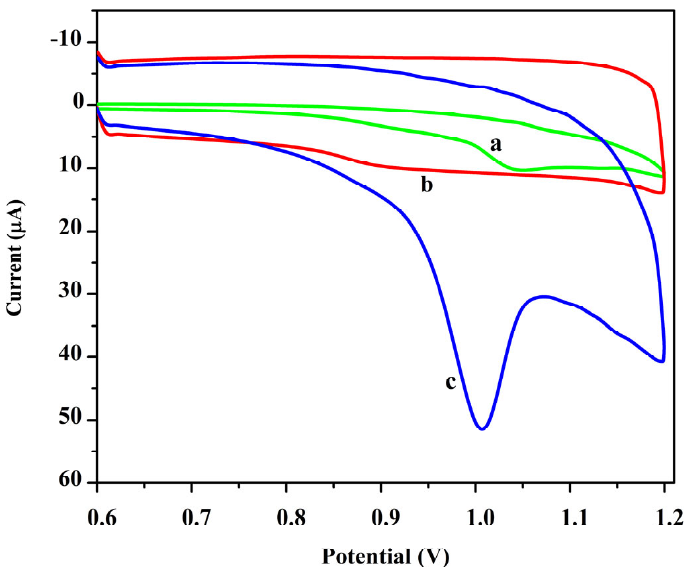
Figure 5. CVs observed for 0.1 M of LN on BCPE ( a ), EPGNLCPE ( c ) and a blank ( b ).